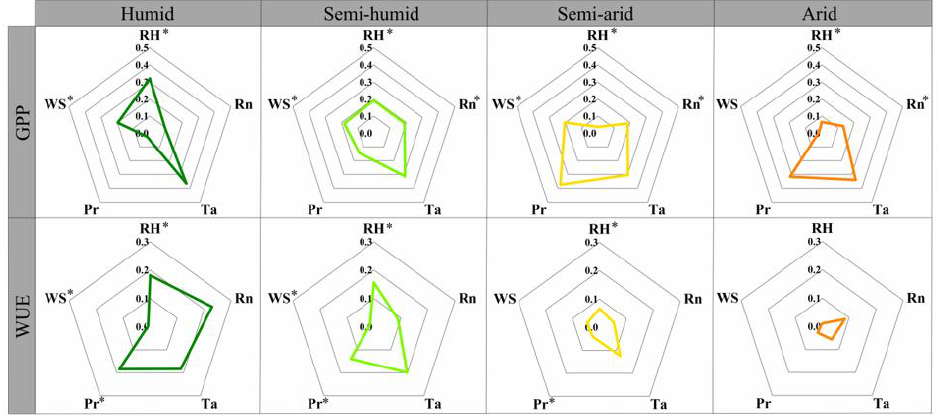
Figure 11. Average correlation coefficients (0~1, unitless) of GPP and WUE with climatic factors in each arid-humid zone. * indicates the negative correlation.